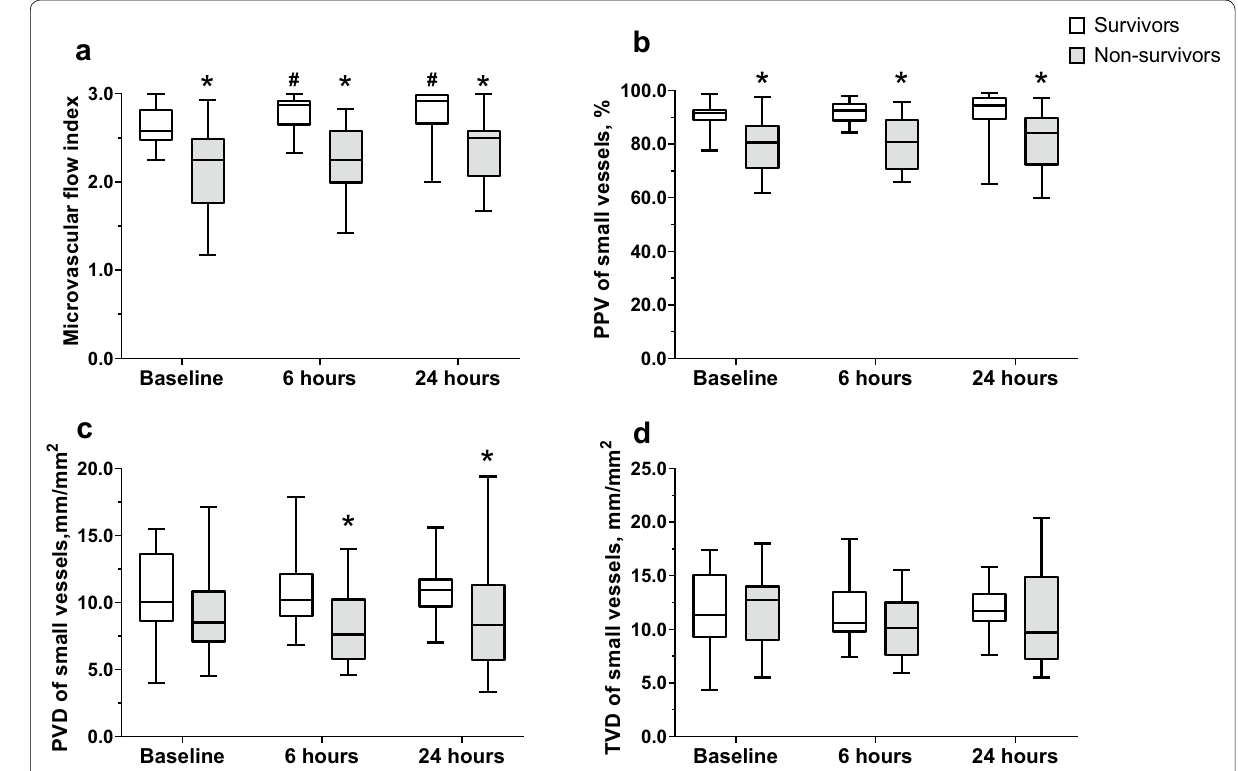
Fig. 2 Box plots demonstrating the time course of microcirculatory perfusion parameters in survivors and non-survivors: a microvascular flow index; b proportion of perfused vessels (PPV) of small vessels; c perfused vessels density (PVD) of small vessels; d total vessel density (TVD) of small vessels. * p < 0.05 between survivors and non-survivors; # p < 0.05 in comparison with